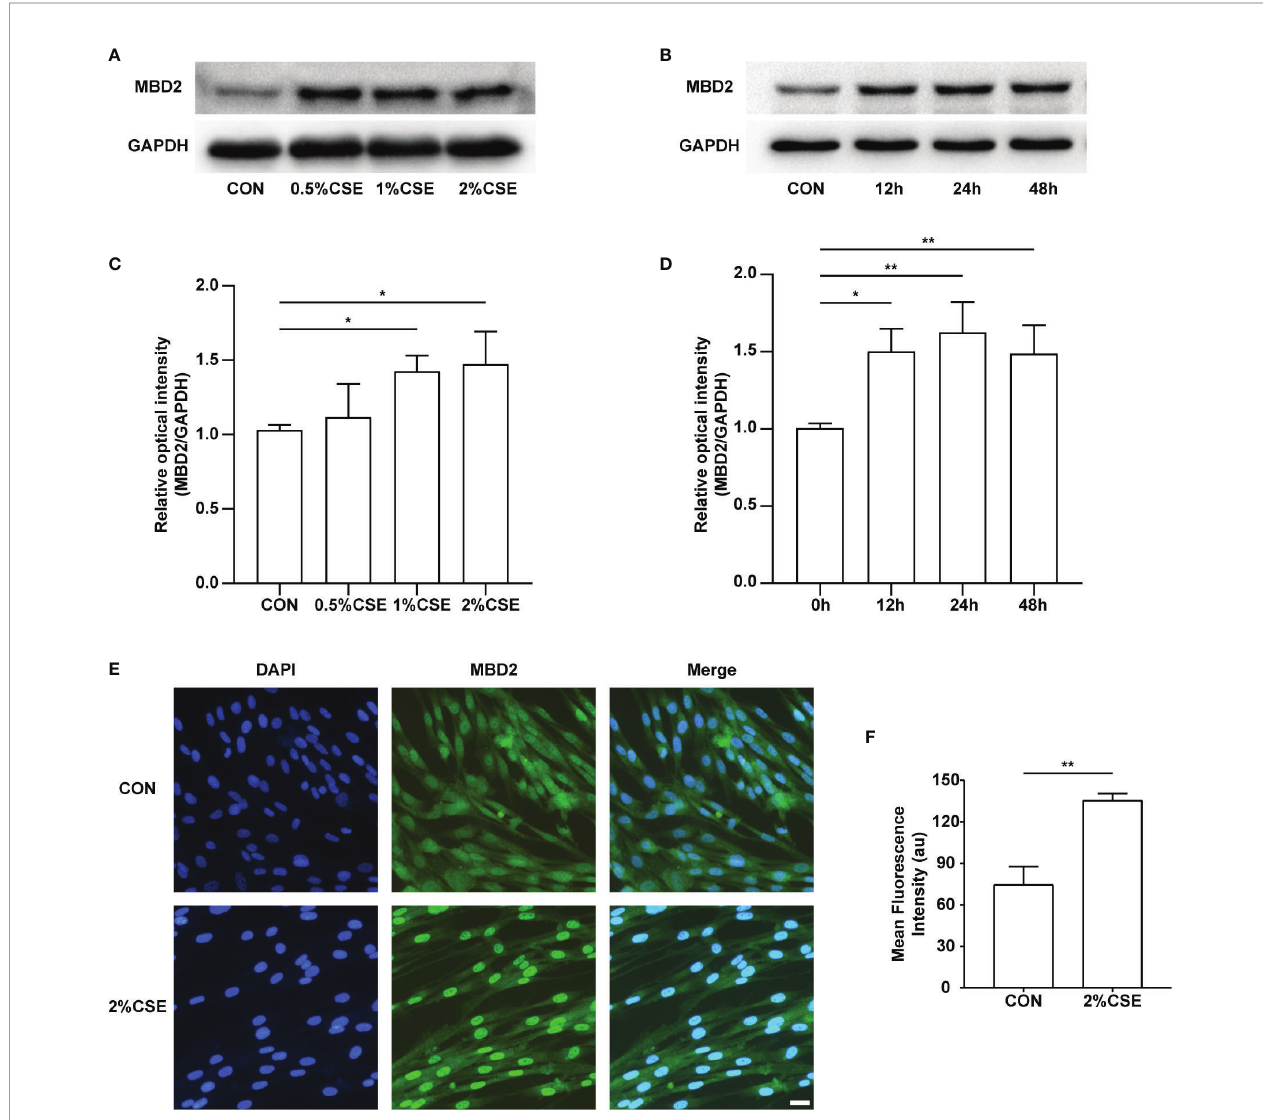
FIGURE 2 | MBD2 protein increases in HPASMCs along with the concentration and duration of CSE stimulation. (A) Representative Western blot images of MBD2 in HPASMCs after stimulation by varying concentrations of CSE for 24h. (B) Representative Western blot images of MBD2 in HPASMCs after 2% CSE stimulation of different durations. (C) Quantitative analysis results of graph A based on the density of the bands. (D) Quantitative analysis results of graph B based on the density of the bands. (E) Representative results for immuno fl uorescence of MBD2 from controls and the CSE stimulation groups for 24h. All images are 200× magni fi cation. Scale bar = 50 m m. (F) Mean fl uorescence intensity of the MBD2 in HPASMCs. The data are presented as mean ± SD, n=3. * P < 0.05, ** P <